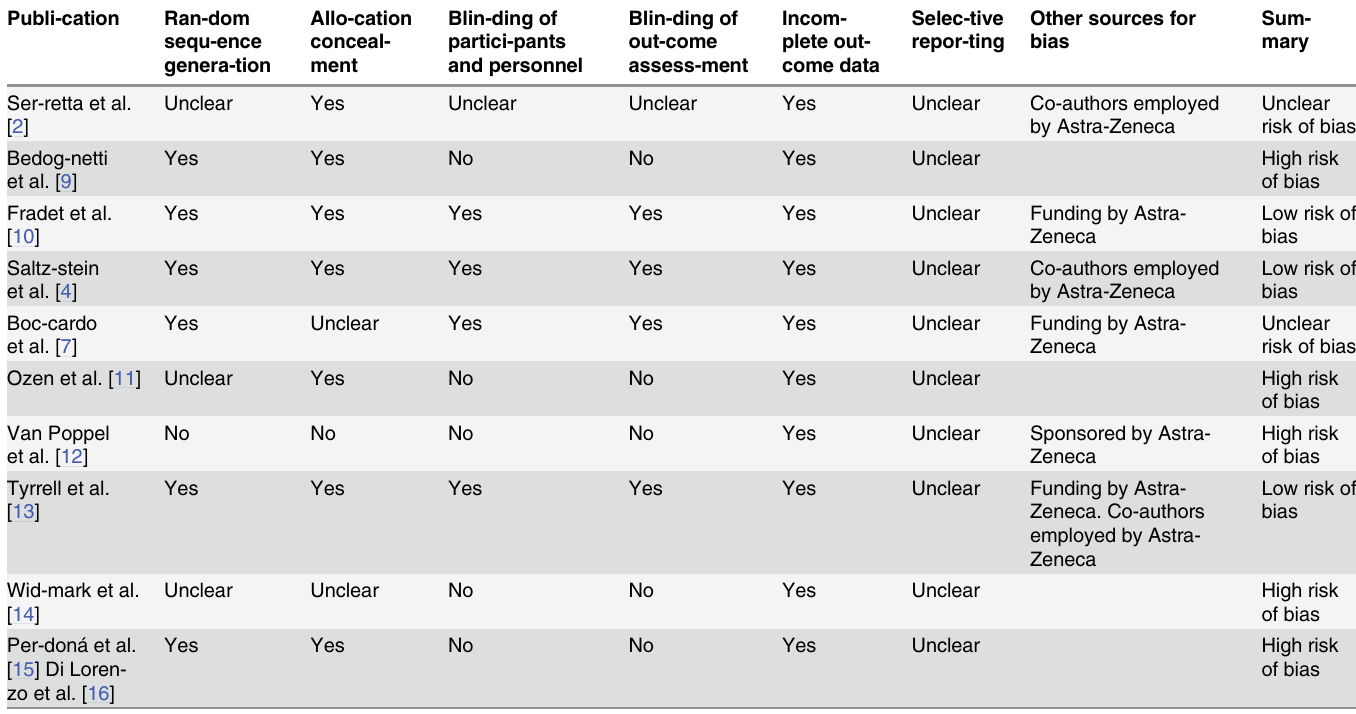
Table 2. Risk of bias according to The Cochrane Collaboration's 'Risk of bias' tool.